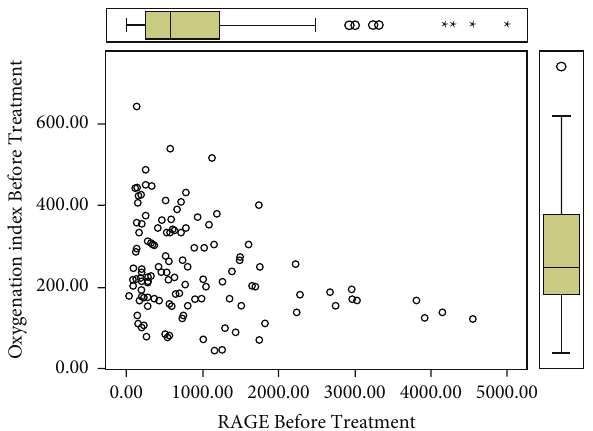
Figure 1: In order to examine the relationship between oxygen- ation index and the RAGE, we calculated the Pearson correlation coefficient, with − 0.228, p � 0 . 001 indicating a meaningful negative correlation between RAGE and oxygenation index.